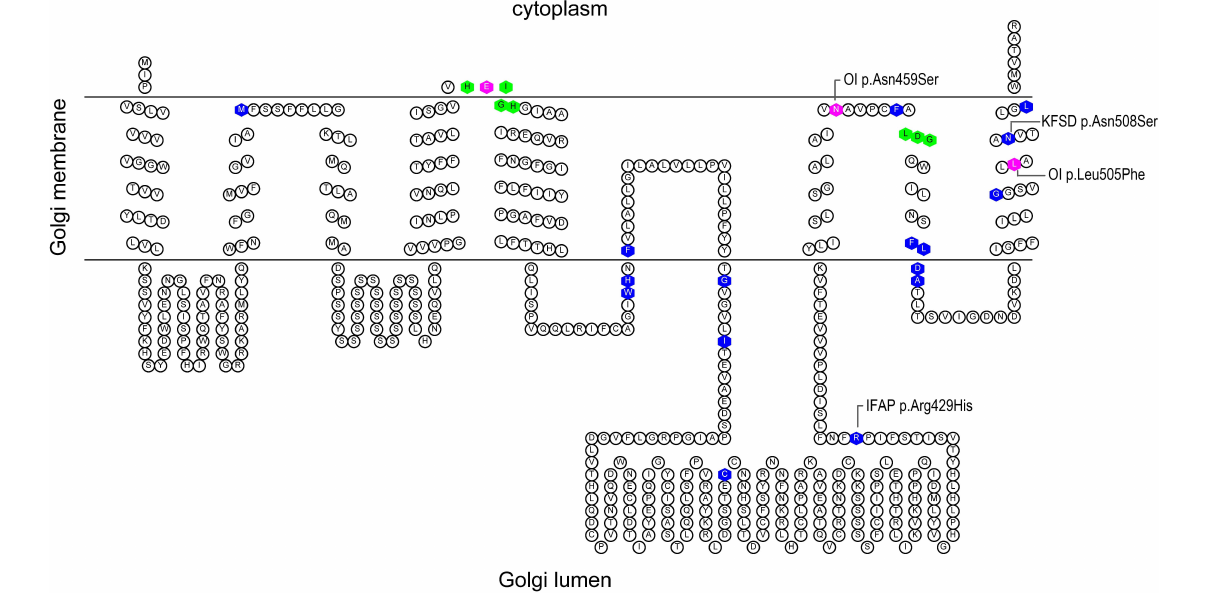
FIGURE 1 | Predicted secondary structure of S2P based on Uniprot topology annotations. The figure was generated using the TOPO2 display software for transmembrane proteins (Johns, 2020). The histidine residues of the His-Glu-(any amino acid) 2 -His (H 171 EXXH) motif and aspartate residue of the L 466 DG sequence, depicted in green, coordinate the catalytic site zinc atom of S2P. Known IFAP/KFSD-causative variants are depicted in blue; OI-causative variants are depicted in